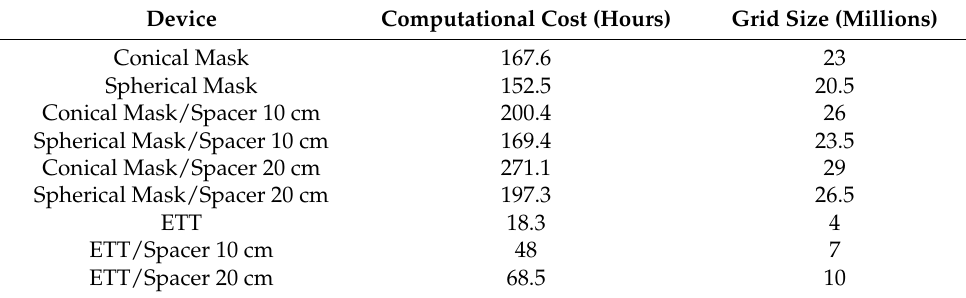
Table 1. Computational cost and numerical discretization of each model.